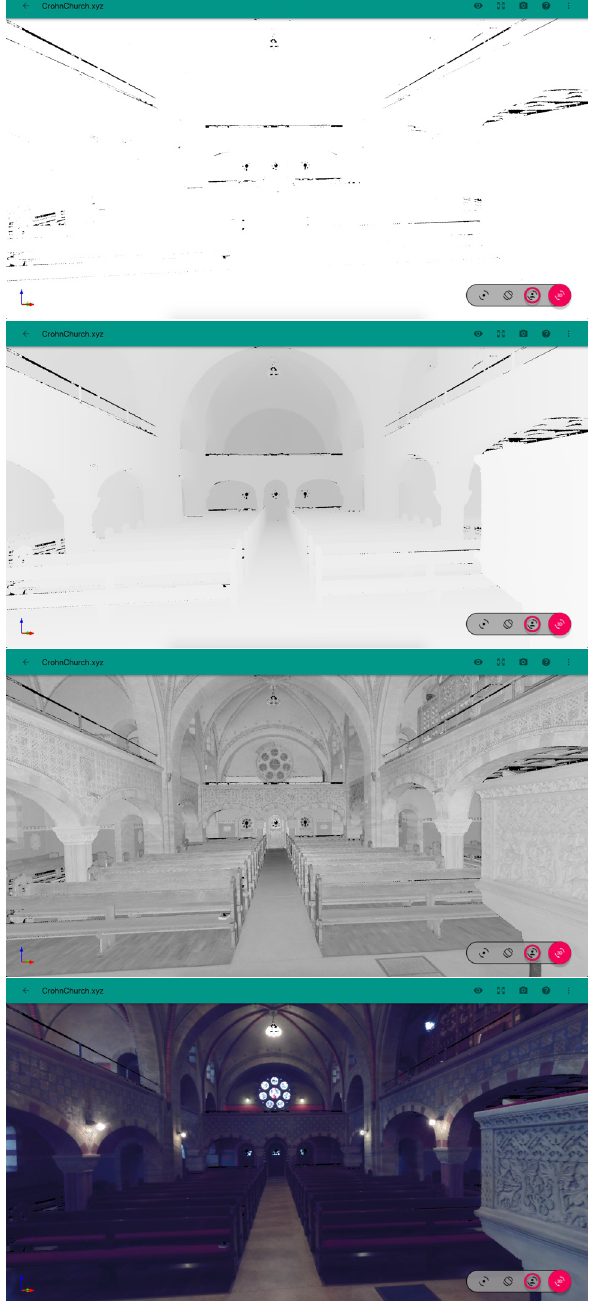
Figure 3 . Representation of different modality of point cloud vi- sualization. From top to bottom the image contains data with raw points, raw points with 3D depth option, raw points with re- flectance and raw points with RGB